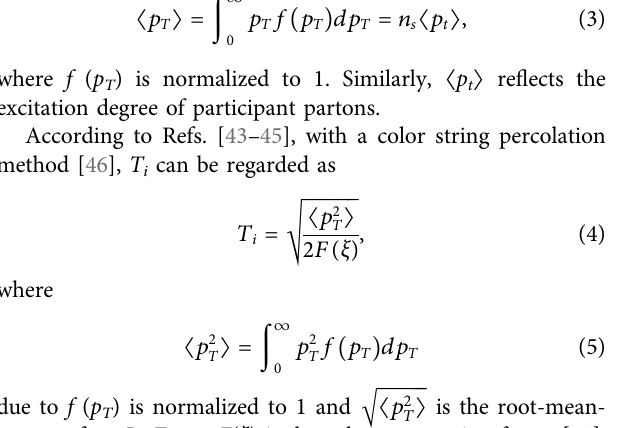
Frontiers in Physics |